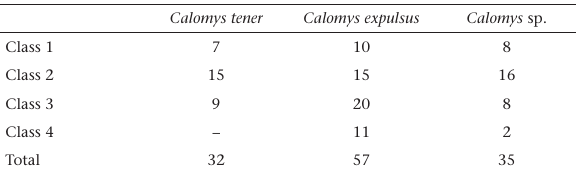
tener and on average 4.0 mm (range 3.8–4.2 mm) in C. expulsus Table 1. Specimens examined and the respective sample sizes by dental wear